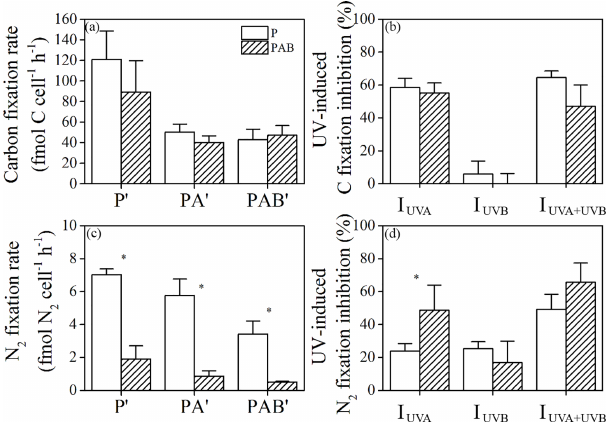
Figure 6. Photosynthetic carbon fixation rate ( a ; fmolCcell − 1 h − 1 ) and UV-induced C fixation inhibition (b) , N 2 fixation rate ( c ; fmolN 2 cell − 1 h − 1 ) , and corresponding UV-induced N 2 fixation inhibition (d) of Trichodesmium IMS101 grown under solar PAR (P) and PAR + UVA + UVB (PAB) trans- ferred to other P (cid:48) , PA (cid:48) and PAB (cid:48) treatments. The measurement was taken on the 18th day at 11:00–13:00. Asterisks above the histogram bars indicate significant differences between P and PAB treatments. Values are the mean ± SD for triplicate